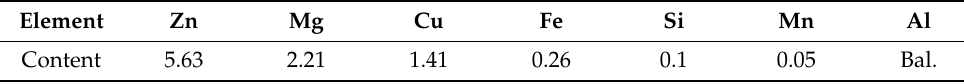
Table 1. Chemical composition of 7075 alloy (wt